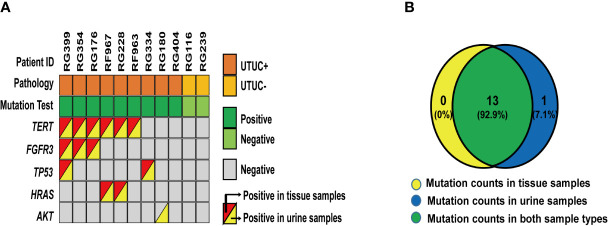
Variants detected in 12 paired urine and tissue samples: (A) A heatmap shows variants detected in 12 paired urine and tissue samples. (B) A Venn diagram shows the relationship of these 26 variants from each set of different types of samples.